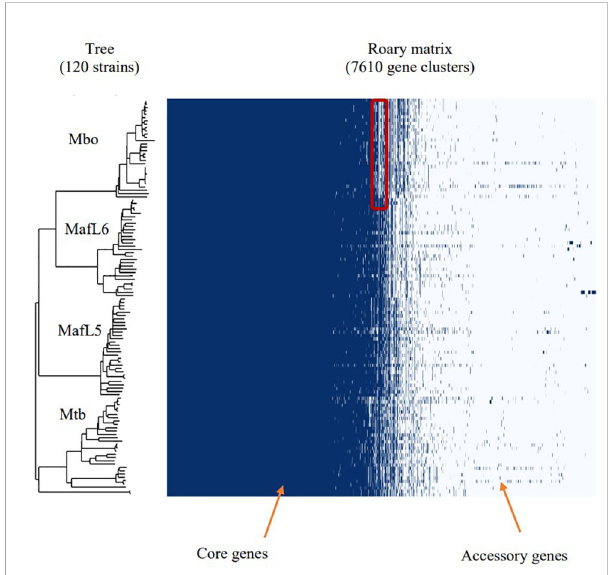
FIGURE 2 Phylogenetic tree together with pangenome distribution of genes within the MTBC – M. tuberculosis, M. africanum and M. bovis . The phylogenetic tree was constructed via identi fi cation of core genome SNPs using ParSNP tool. Roary matrix obtained from pangenome analysis shows the distribution of core and accessory genes within the MTBC. The highlighted section of the M. bovis genomes shows deletions which are characteristic of M. bovis as RD4, RD7, RD8, RD9 and RD12